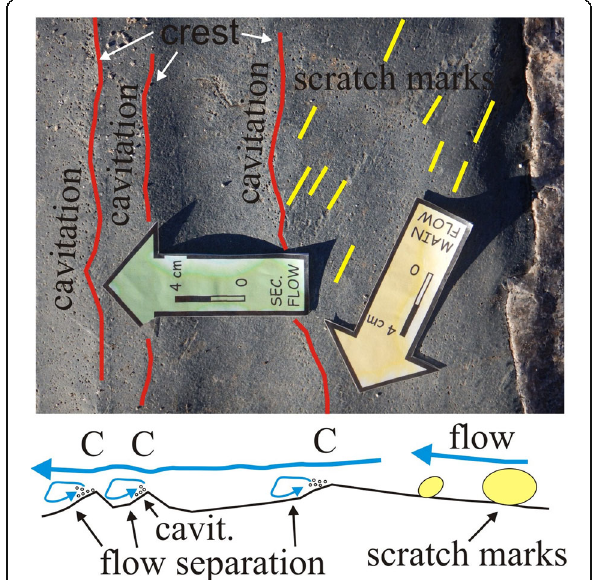
Fig. 13 An interpretation of the image shown in Fig. 10. Crests and troughs in a microdiorite dyke. Scratch marks superimposed on gentle convex stoss slopes form following the direction of the main flow. Pseudo-ripples crests develop perpendicularly to a secondary flow. The secondary flow could generate cavitation on steep concave lee slopes, forming pits as a consequence of the small crystal size and higher weatherability of